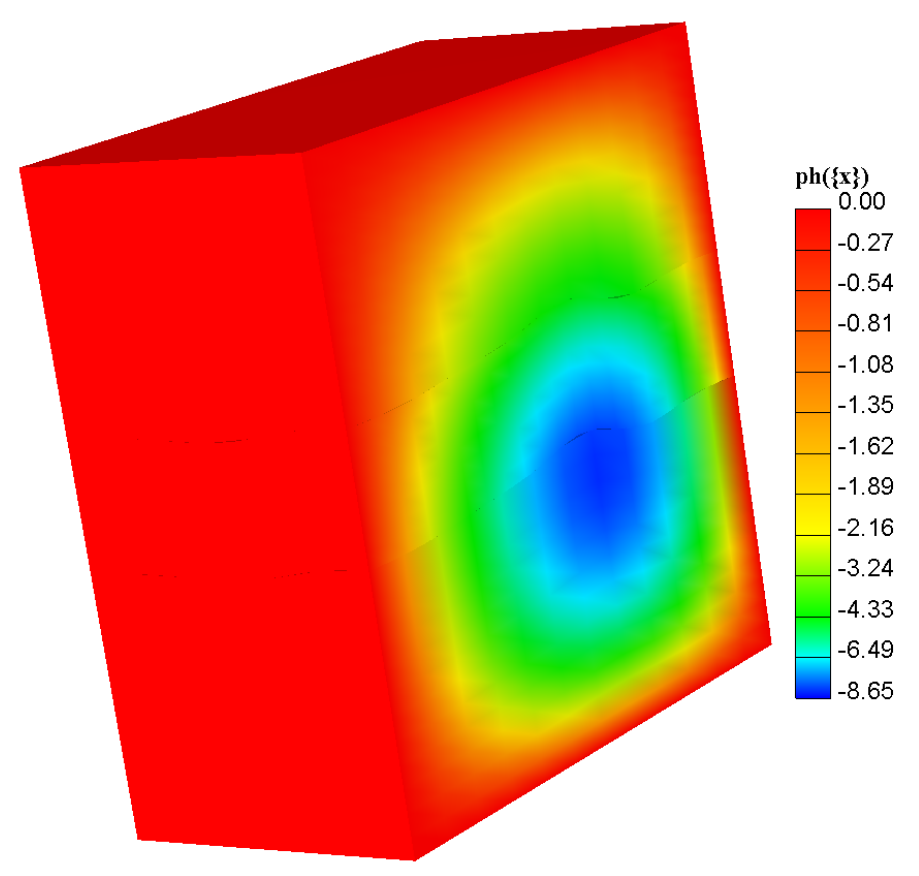
Figure 11. DNDDM solution to Example 1 in Section 5.1.